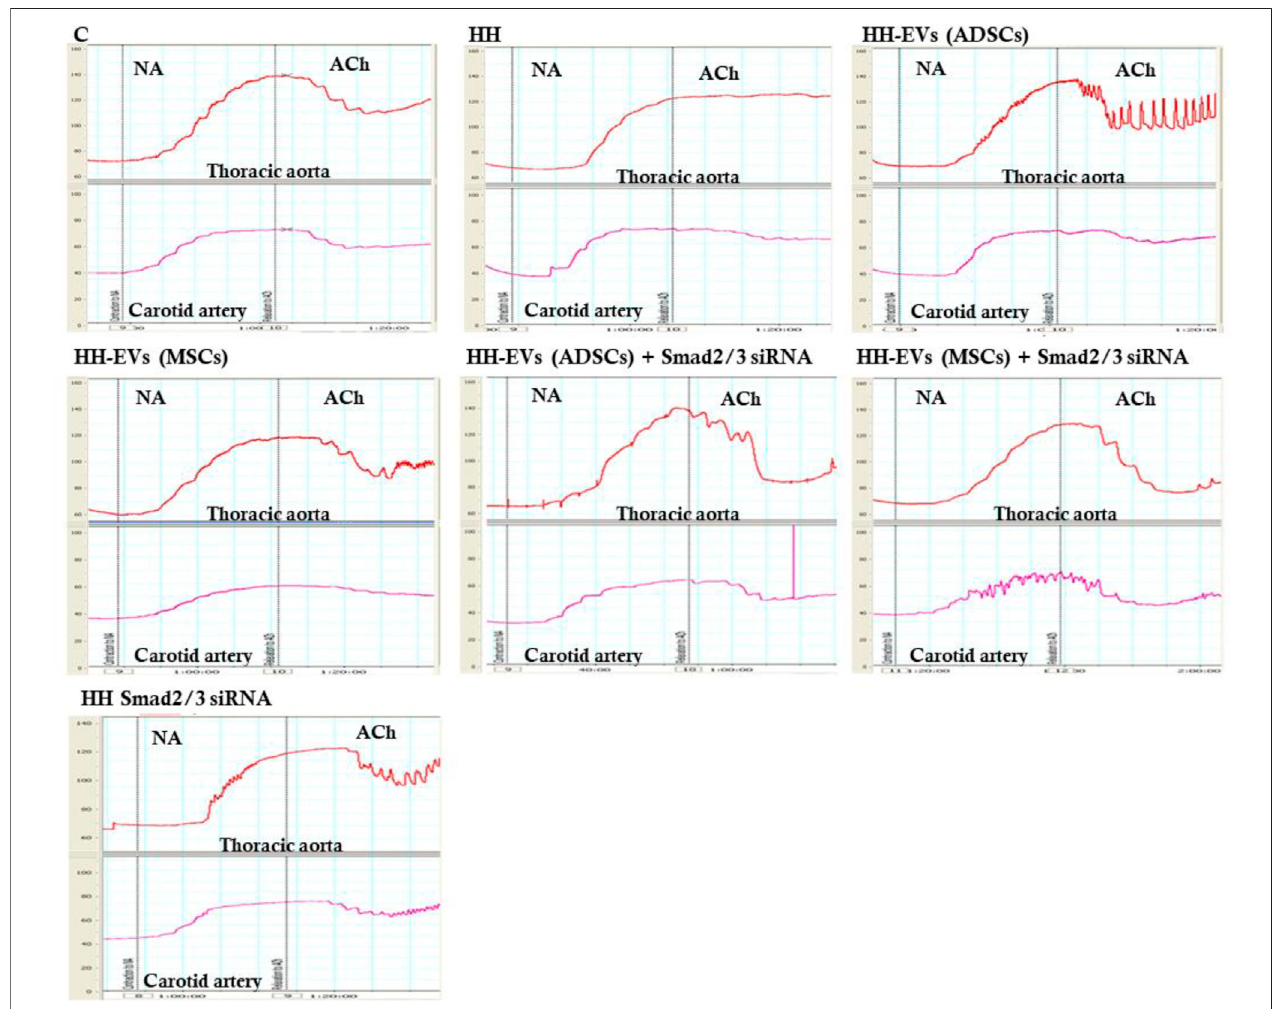
FIGURE 6 | Representative images with myograph recordings at selected time points: for the contraction function to NA (10 − 8 M ÷ 10 − 4 M) and relaxation to ACh (10 − 8 M ÷ 10 − 4 M) in the thoracic aorta (red) and carotid artery (purple) in all investigated experimental groups: C, HH, HH-EVs(ADSCs), HH-EVs(MSCs), HH- EVs(ADSCs)+Smad2/3siRNA, HH-EVs(MSCs)+Smad2/3siRNA, and HH-Smad2/3siRNA. Images were recorded with LabChart 7 software.